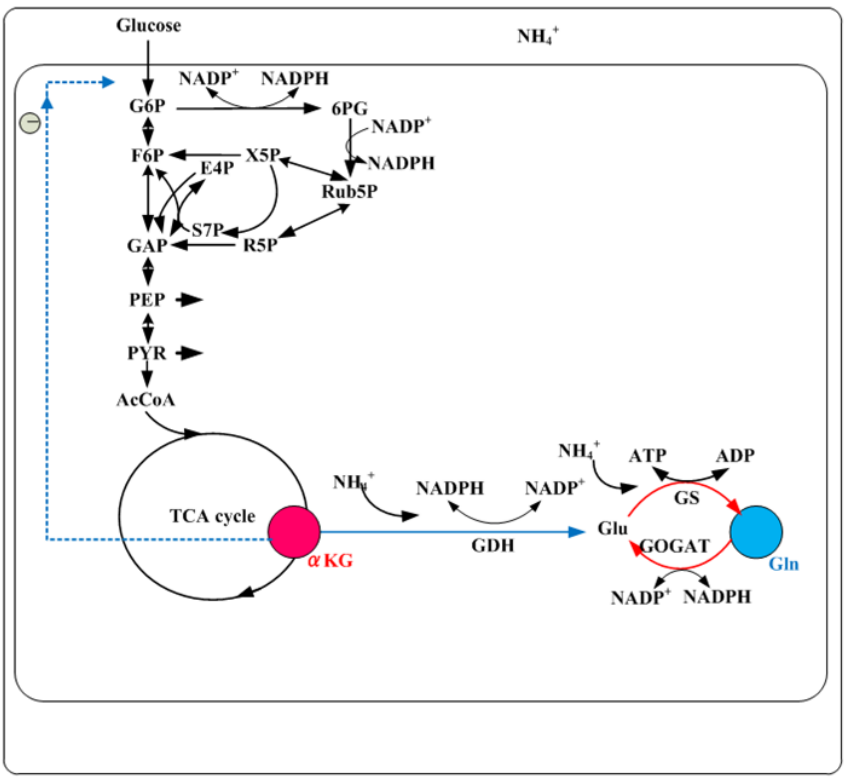
Figure 5. NH assimilation pathways and the regulation under 3